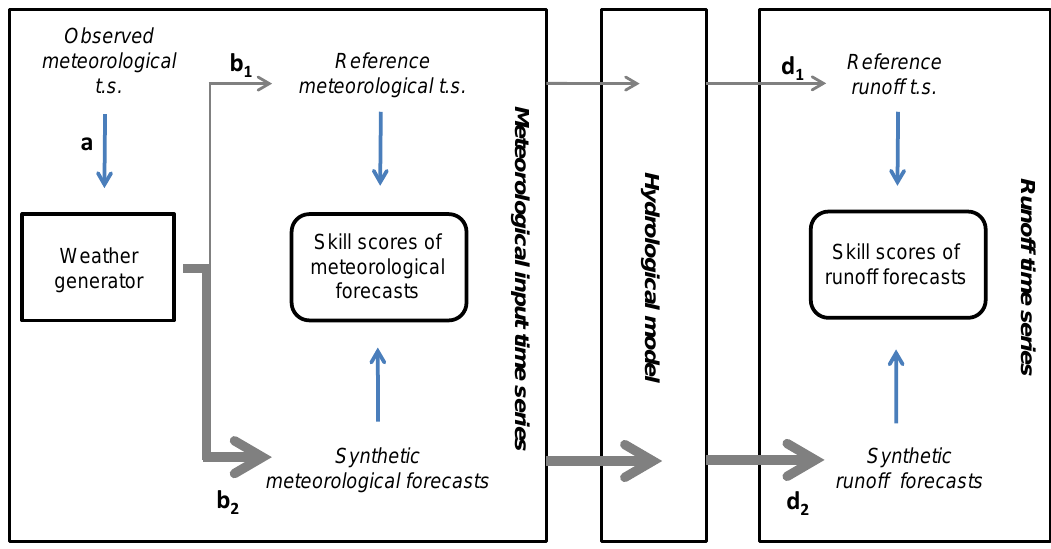
Figure 1. General methodological workflow. The three boxes represent the different working steps. The thin grey arrows are the reference time series (t.s.) while the thick grey ones are different synthetic forecasts. Blue arrows indicate input data.